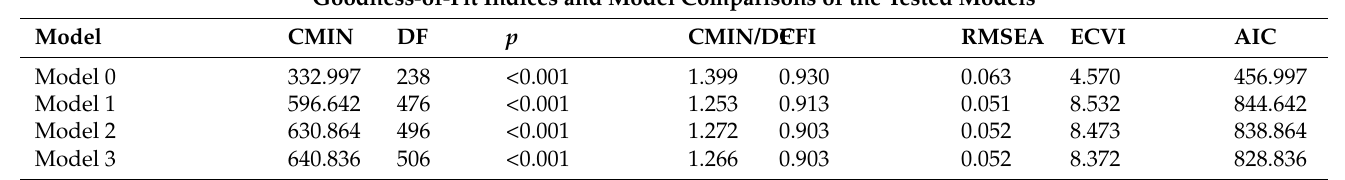
Table 1. Statistics adjustment for the ‘sexual experiences questionnaire’, Department of Defence (SEQ-DoD) scale model; comparison between models using Model 1 as correct.